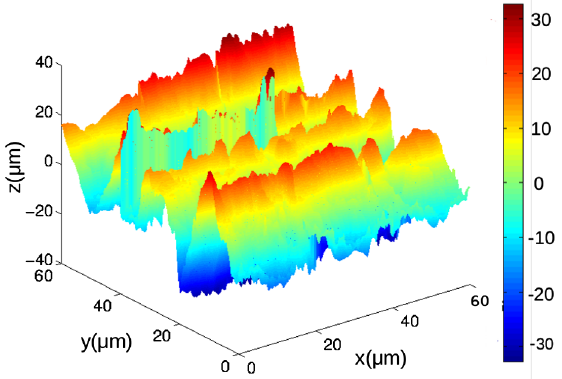
FIG. 12. Merge of 9 adjacent images scans for aluminum sample #2.